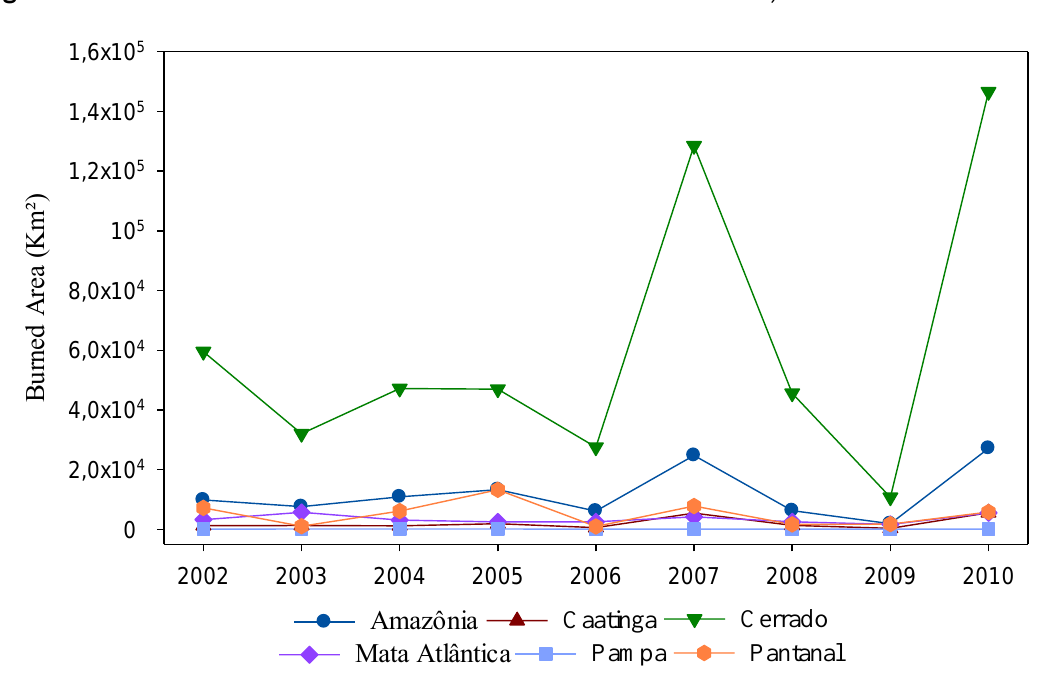
Figure 3. Distribution of the burned areas in the Brazilian biomes, between 2002 and